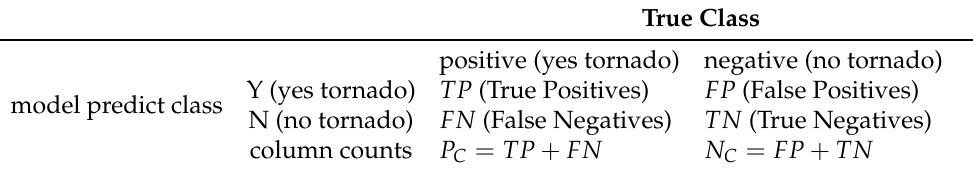
Table 3. Binary confusion matrix.